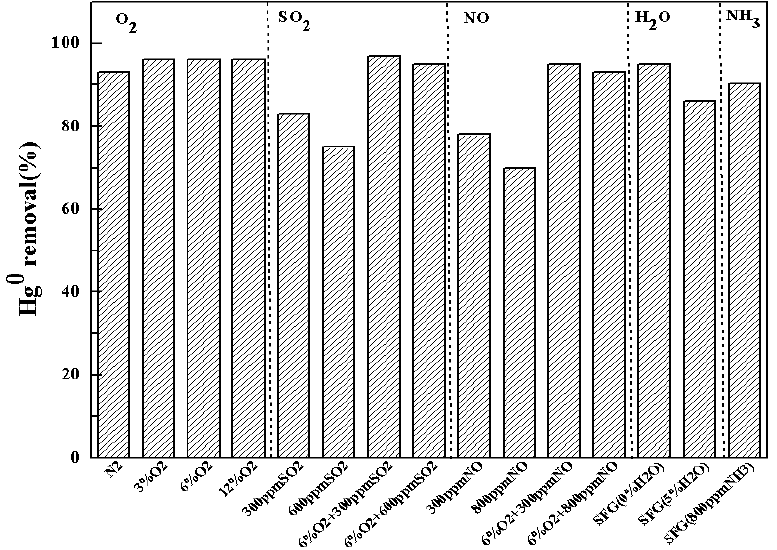
Figure 8. Effect of the flue gas components on Hg 0 removal over the Ce-Mn-Fe/GO-20% sample at 170 °C.